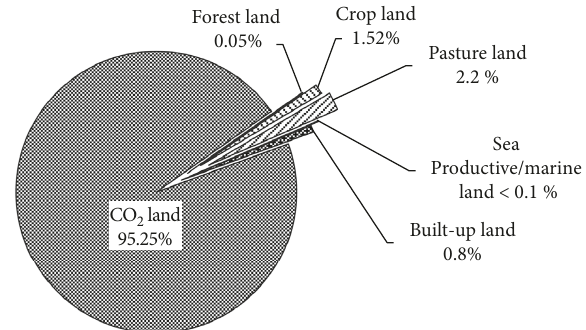
Figure 7: Involvement of different bioproductive lands during the building lifespan.